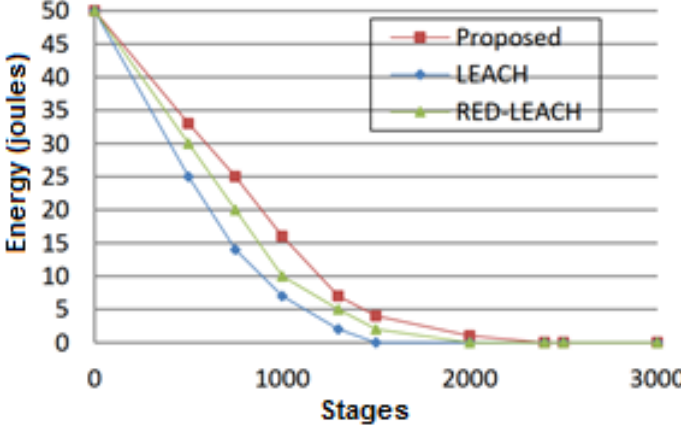
Figure 10. Average residual energy in each stage.